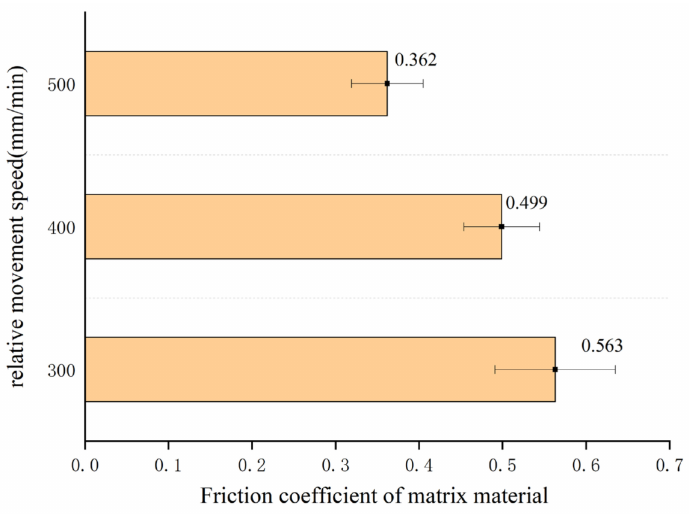
Figure 18. Friction coefficient of matrix material at different relative movement